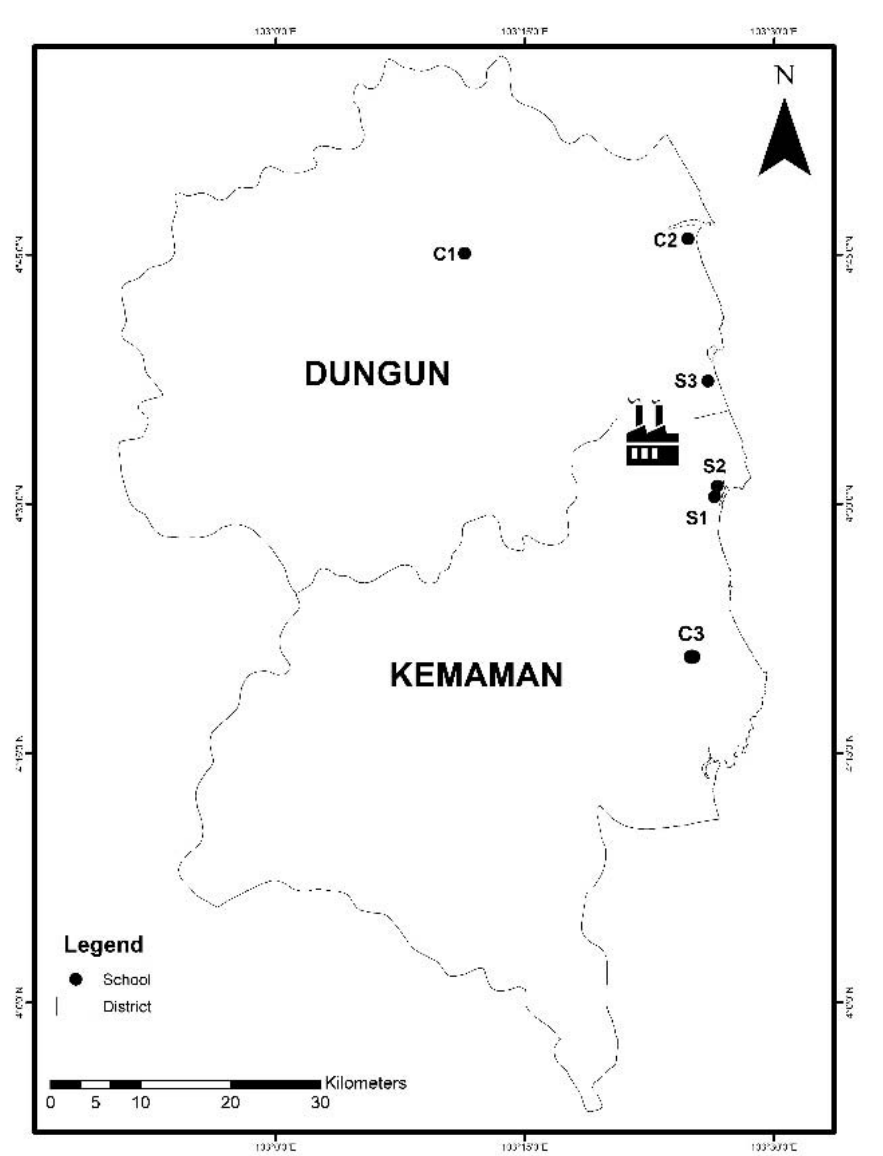
Figure 1. Map of peninsular Malaysia and the study area (Terengganu State). The six schools are located in the districts of Dungun and Kemaman, Terengganu.